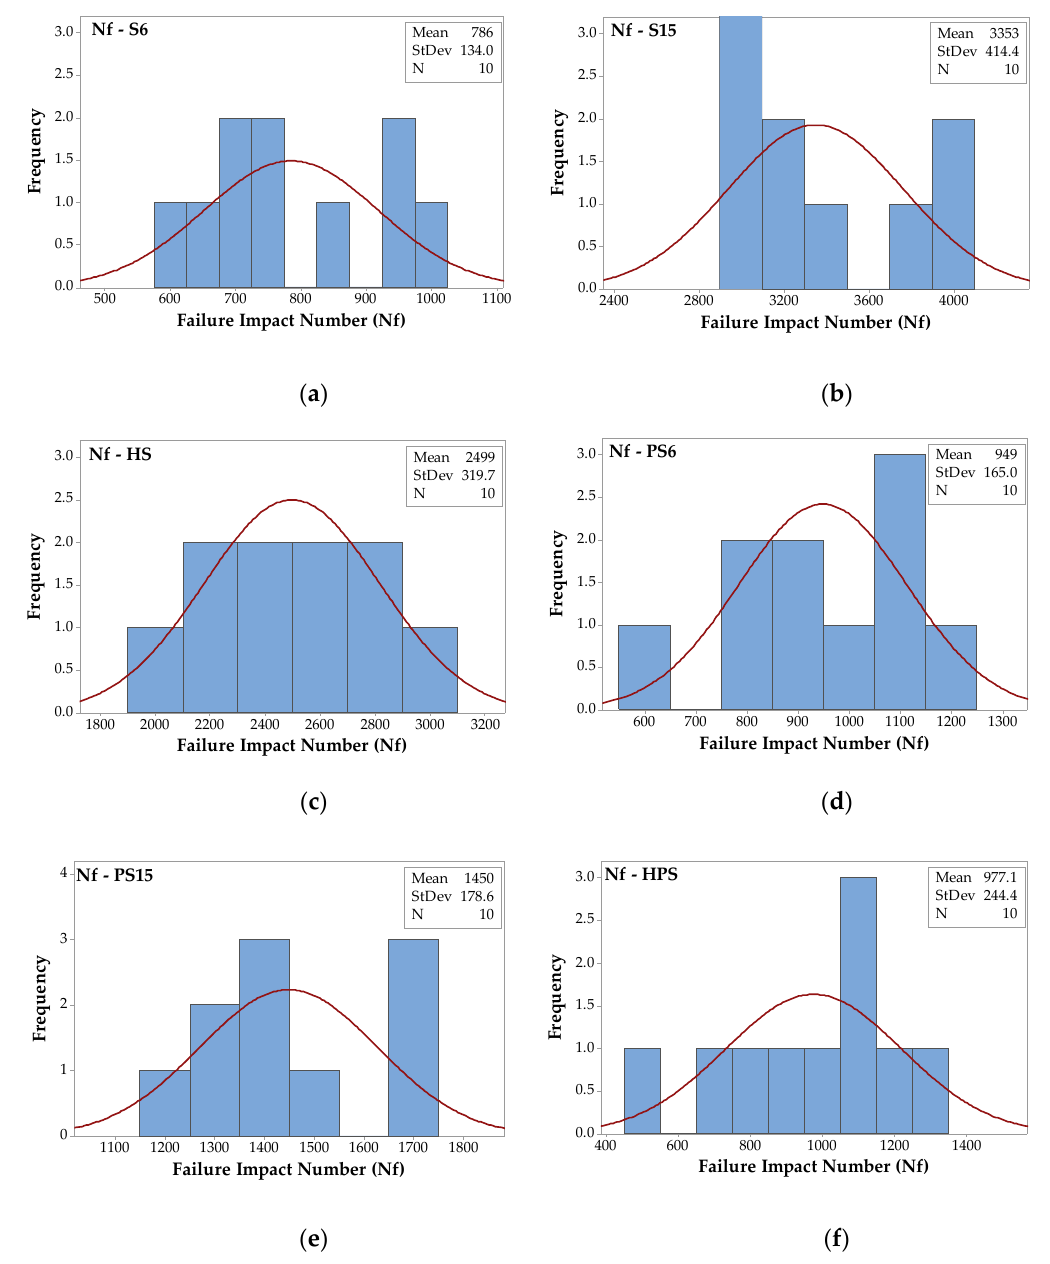
Figure 11. Normal distribution histogram of the cracking impact number Ncr. ( a ) S6; ( b ) S15; ( c ) HS; ( d ) PS6; ( e ) PS15; ( f ) HPS.